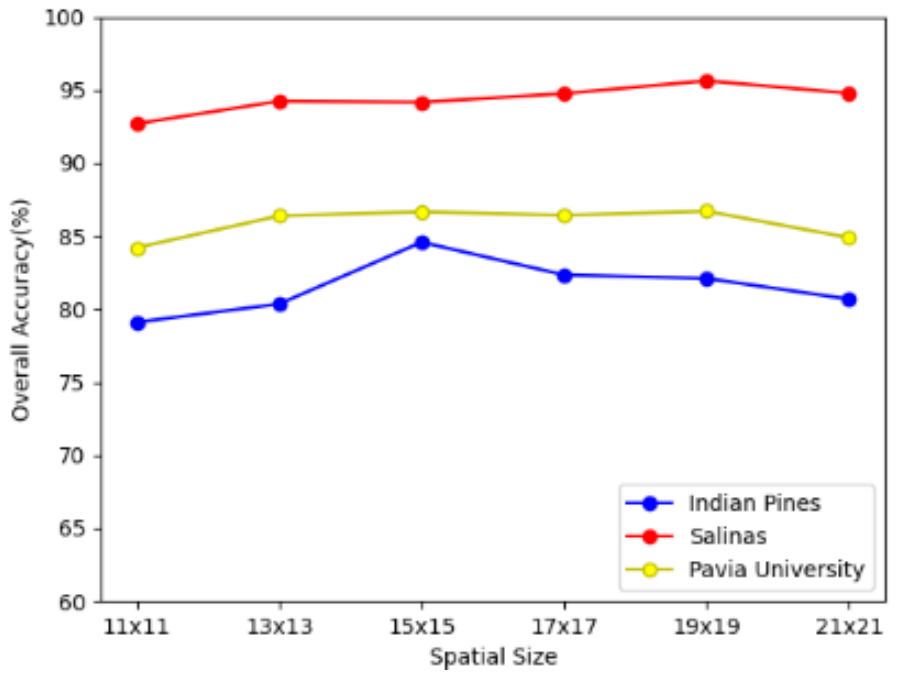
Figure 10. OA of the proposed model using different spatial size in three HSI datasets. The spectral dimension represents how much spectral information in the extracted 3D patch can be used to classify the HSI. This paper validates the effect of spectral dimension on model performance on three datasets. In the experiment, the spectral dimension was set to {20, 25, 30, 35, 40, 45}, and the spatial size of the three datasets of IP, PU and SA were set to 15 × 15, 19 × 19, 19 × 19, respectively. As can be seen from Figure 11, for IP, PU and SA datasets, the most suitable spectral dimensions for the proposed model were 30, 20 and 30, respectively.